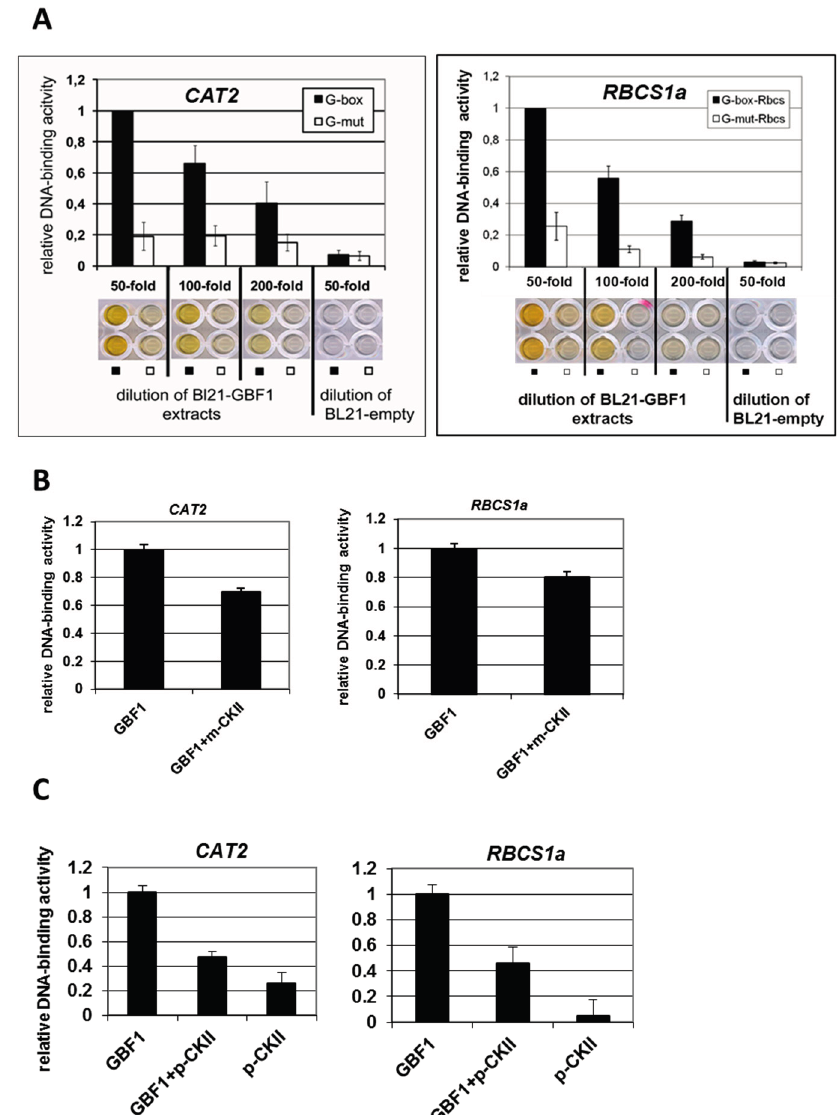
Figure 2. DPI-ELISA using recombinant GBF1 with the G-box of the CAT2 and the RBCS1a promoter. Biotinylated plate coupled DNA fragments containing either the G-box (black bars) or a mutated version (G-mut; white bars) were incubated with crude E. coli BL21 extracts expressing recombinant 6×His-tagged GBF1 in different dilutions or the empty vector. Colorimetric reaction was quantified with a plate reader and plates were also photographed. The interactions between 50-fold diluted crude extracts and the G-box were set to 1.0, and all other interactions are expressed as relative values referring to GBF1/G-Box. ( A ) Concentration-dependent DNA-binding reaction of crude E. coli BL21 extracts expressing recombinant 6×His-tagged GBF1 with the G-box containing fragment of the CAT2 promoter (left) or of the RBCS1a promoter (right); ( B ) DPI-ELISA after pre-incubation with or without mammalian CKII (m-CKII); ( C ) DPI-ELISA after pre-incubation with or without plant CKII α subunit 2 expressed in E. coli (p-CKII). Error bars indicate SE ( A ) or SD ( B and C ) of 2–6 independent